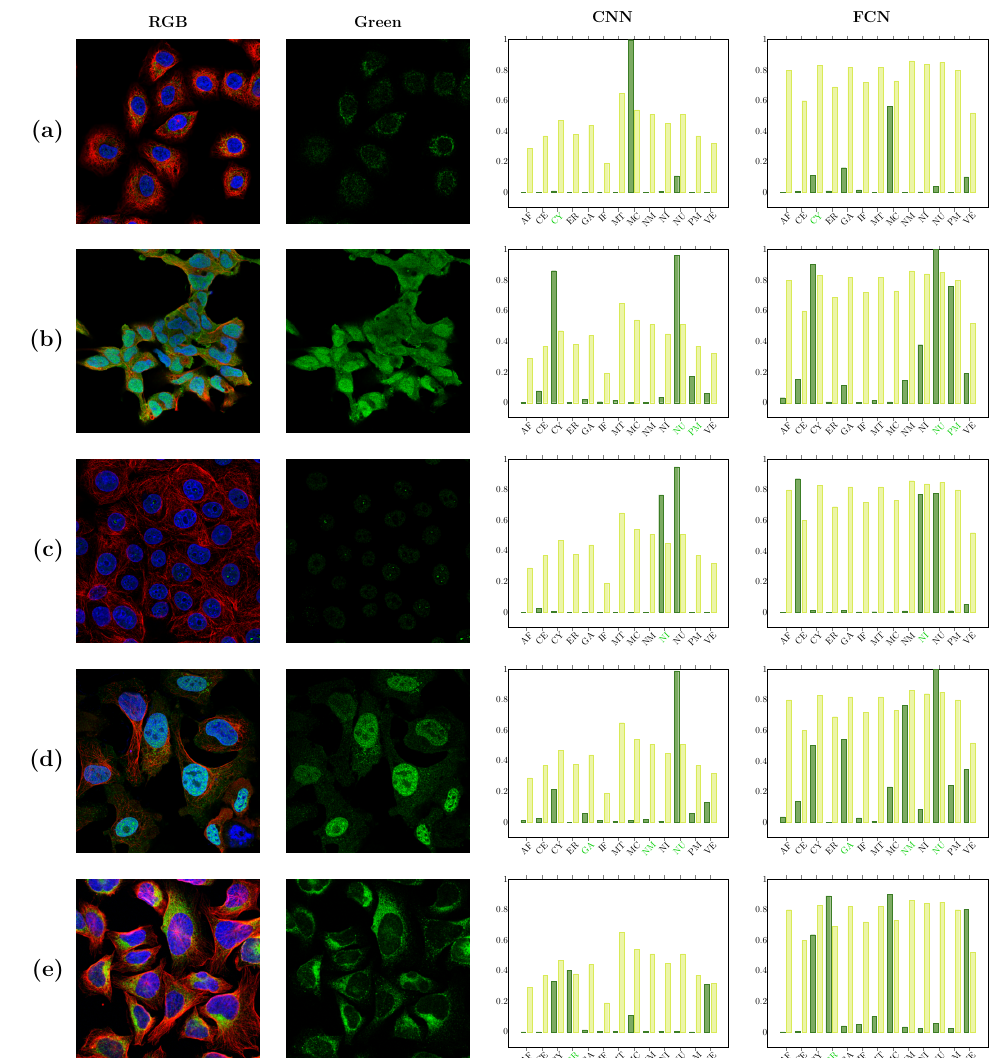
Figure 6. Examples of unsuccessful classification. Confidence values are represented with dark green in the plots, and thresholds for each class are lighter bars. The annotated classes are labeled in green. Unsuccessful classification can result from clear misannotations of the only or one of the several localizations ( a , b ) or low signal intensity ( c , d ). In ( e ), a “true” misclassification is presented. We also studied the effect of different cell lines on the prediction accuracy. As illus- trated in Figure 2, the dataset includes samples from 22 different cell lines.Three of the cell lines, ‘U-2 OS’, ‘A-431’ and ‘U-251’ are the origin for majority of the samples (in total 73.5% of all data, 72.9% of test data), whereas the rest <30% are divided between the 19 remaining cell lines. In Figure 8, the prediction accuracy is presented separately for the three dominant cell lines and for a combined class of the other cell lines. We observed a slight drop in the performance for the low-sample cell lines, especially for FCN, suggesting that the heterogeneity due to the differences in cell lines may introduce an additional challenge to the prediction task. See the supplementary repository for Supplementary Figure S1, where the prediction results are presented separately for all 22 cell